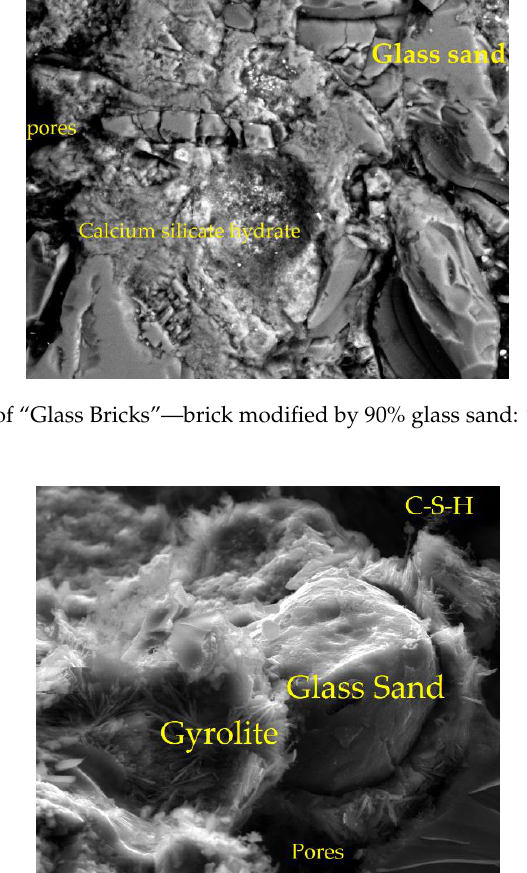
Figure 18. SEM image of “Glass Bricks” — brick modified by 90% glass sand: SEM high-vacuum mode, 3000× magnification.